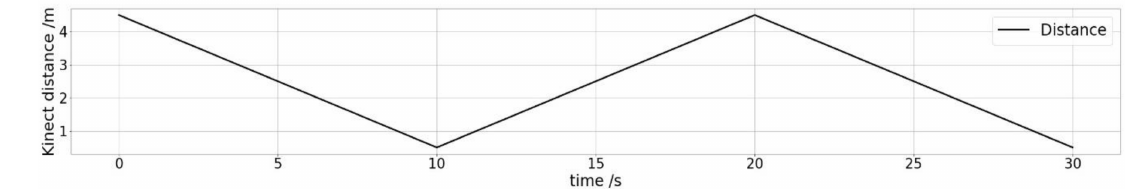
Figure 2. Distances covered during the walking test, always facing the camera.